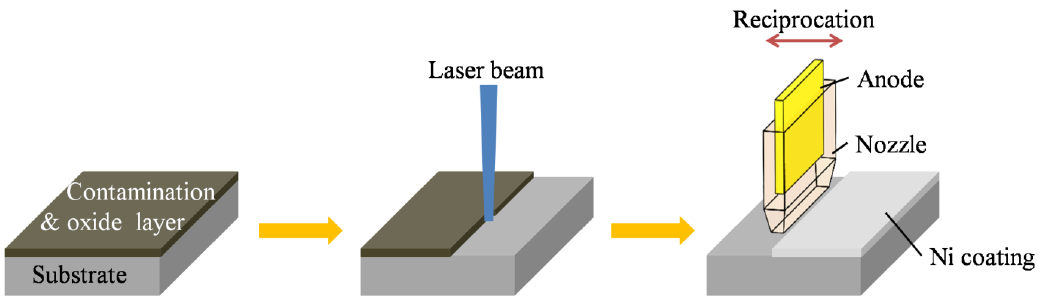
Figure 1. Experimental process.